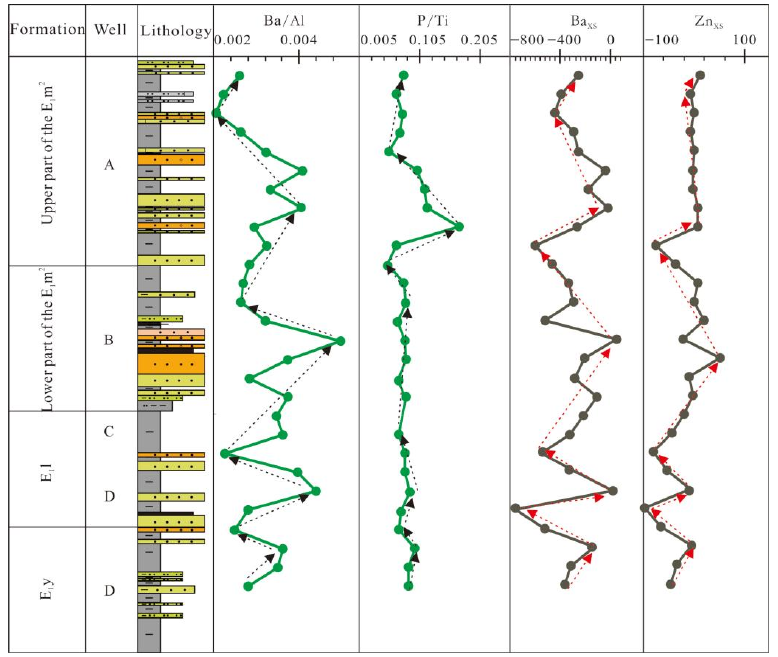
Figure 17. The changing trend of paleoproductivity in the West Lishui Sag.